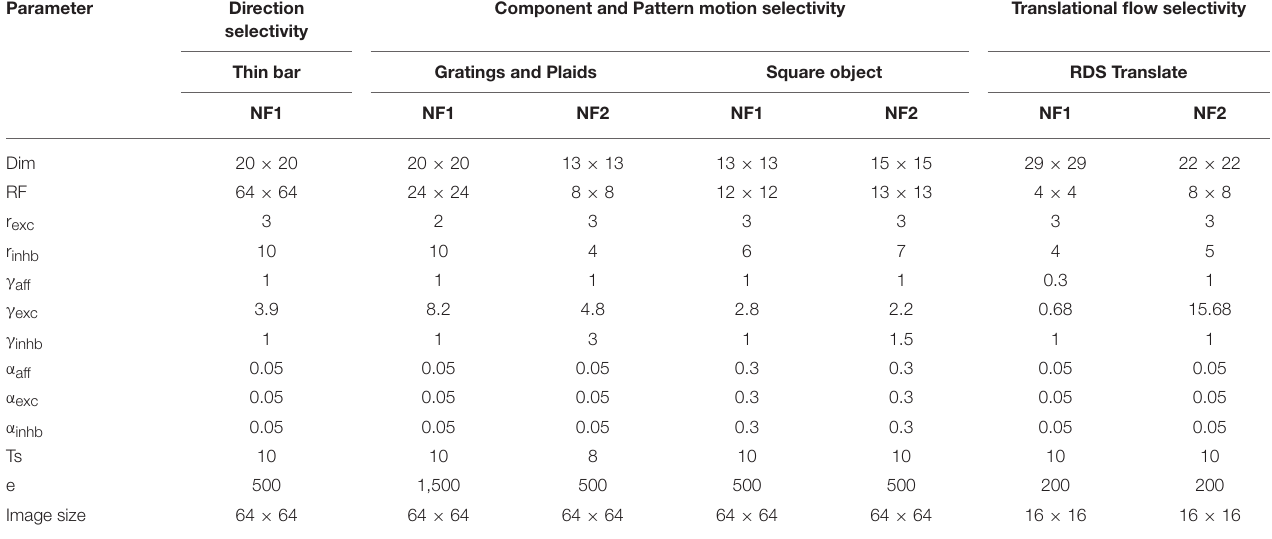
TABLE 1 | Parameters used in various